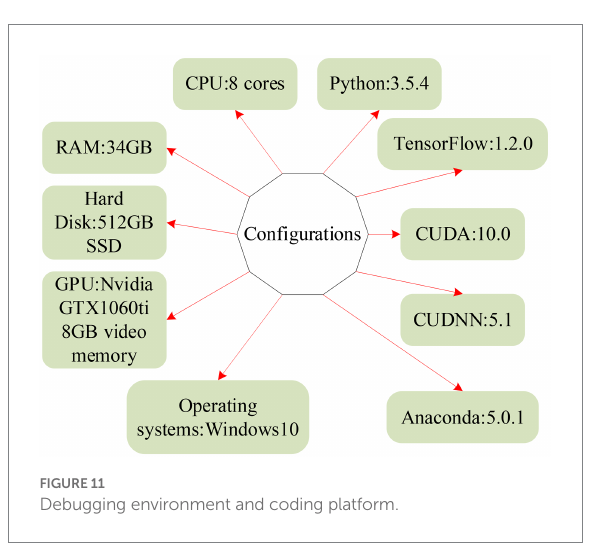
FIGURE 11 Debugging environment and coding platform.